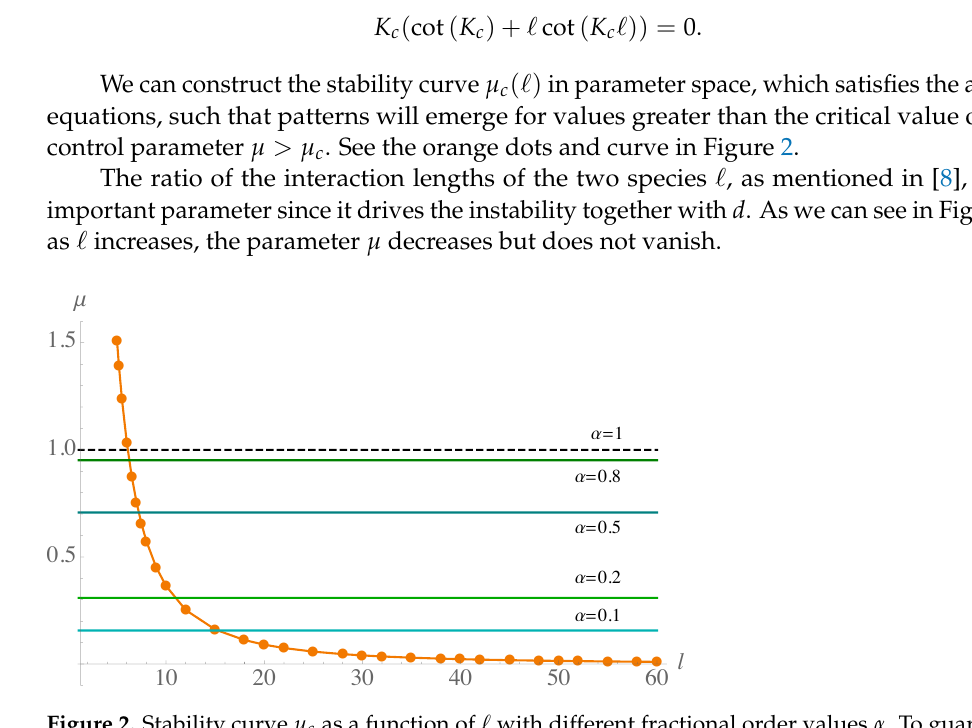
Figure 2. Stability curve µ c as a function of (cid:96) with different fractional order values α . To guarantee pattern formation µ must take values above the orange